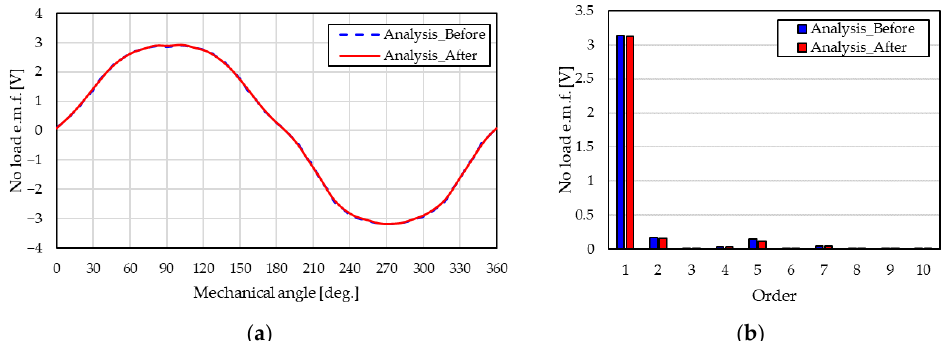
Figure 25. Analytical U-phase back e.m.f. before and after irreversible demagnetization at 1000 r/min: ( a ) waveforms; ( b ) FFT results.